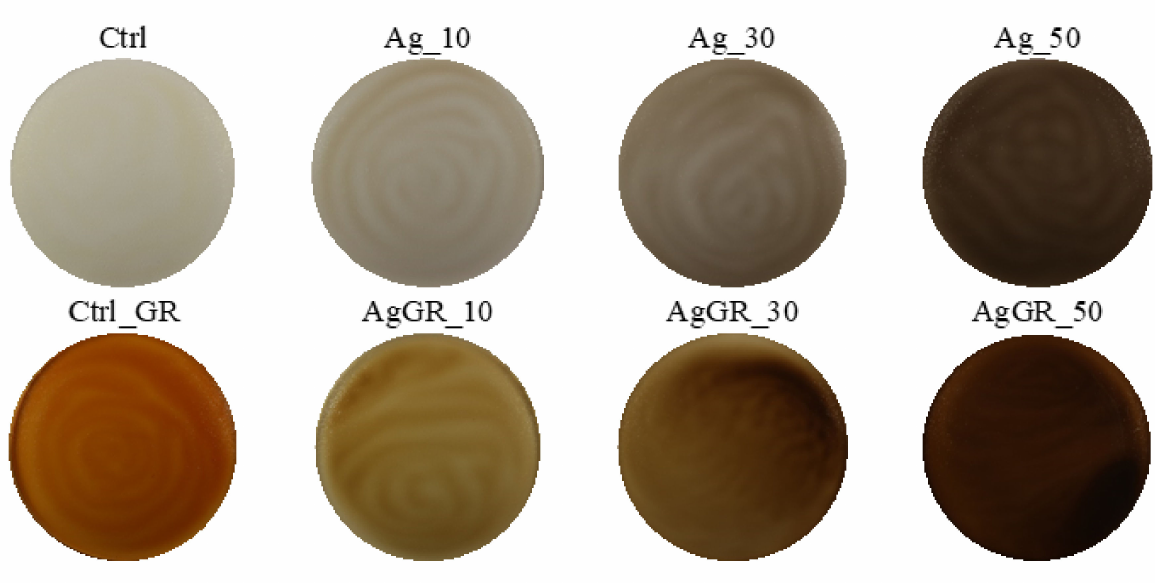
Figure 3. Digital images of edible coatings used for color analysis—samples with the addition of Ag